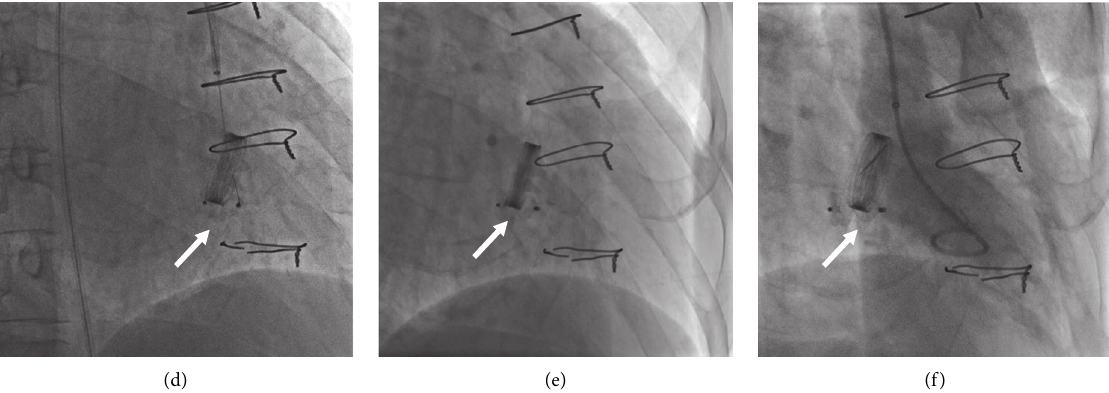
Figure 3: Angiogram taken during the transcatheter procedure of mitral PVL closure via a transfemoral retrograde approach. (a) Left ventricular angiogram to profile the paramitral regurgitation. (b) Retrograde crossing of the paravalvular leak with the guidewire. (c) The introducer sheath was advanced into the left atrium. (d) The occluder device was placed at the position of the paravalvular leak. (e) The occluder device was deployed. (f) Left ventricular angiogram after deployment. The black arrow indicates the PVL. The white arrow indicates the